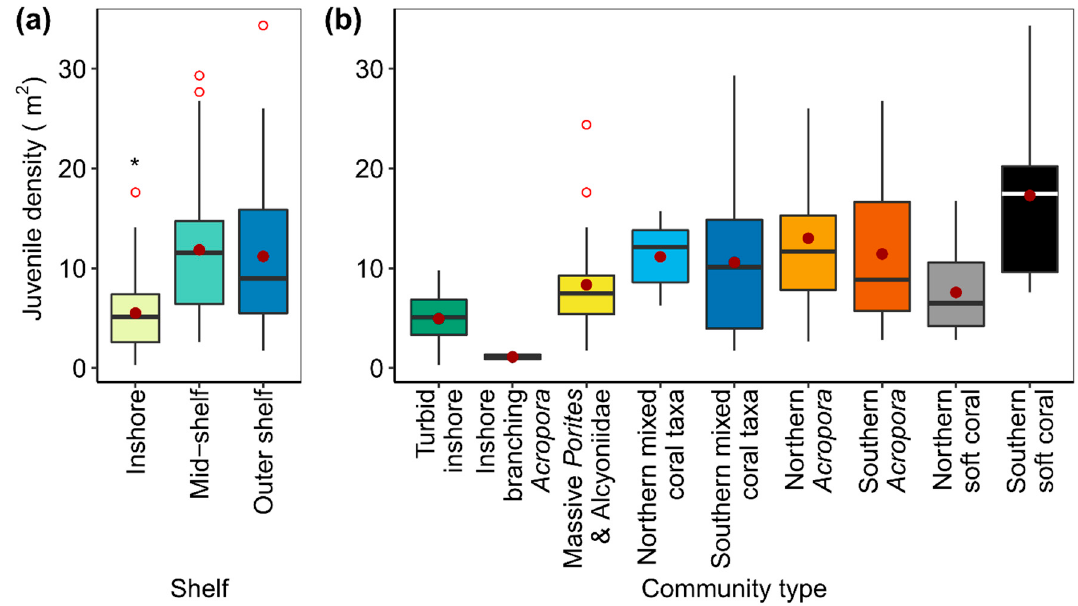
Figure 2. Boxplots of juvenile coral densities on the GBR ( a ) by position across the continental shelf and; ( b ) by community types arranged across the continental shelf from inshore to outer shelf. The line in the middle of each boxplot represents the median, colored portions contain the 25th to 75th percentiles of the observations and bars extent to 1.5 times the interquartile range. Mean values per boxplot are symbolized by a solid dark red circle and outliers represented by open red circles. Refer to Figure 1 for locations of each reef group.